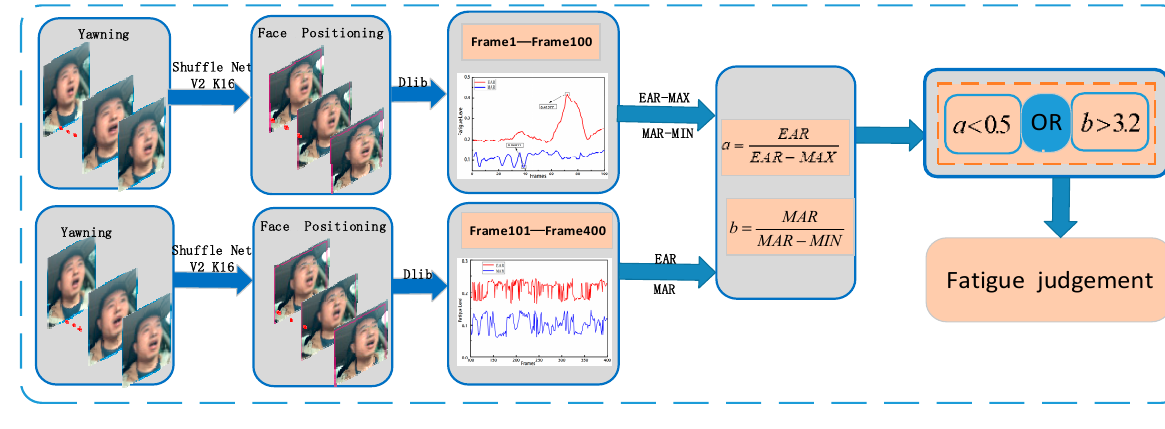
Figure 1. General organizational structure.